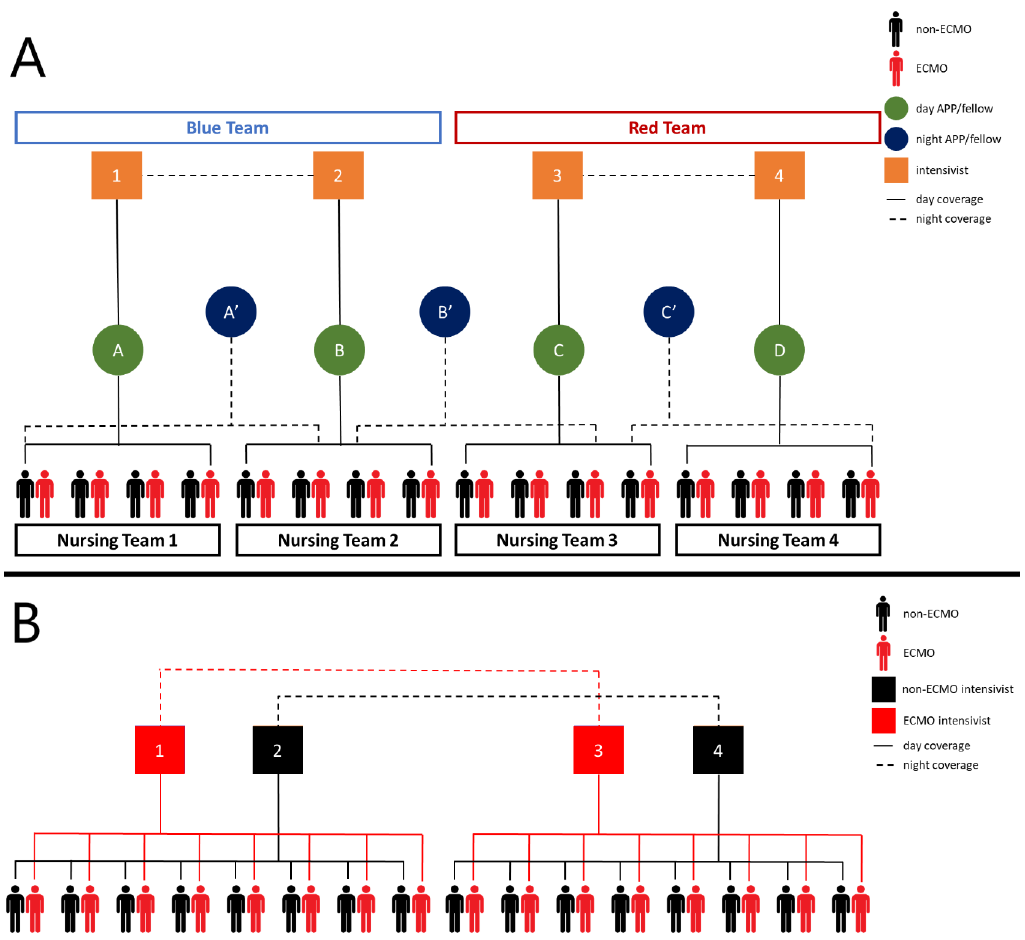
Figure 5. ( A ) Initial intensivist/( B ) provider care team schematic. The biocontainment unit (BCU) is split into two teams. During the day, each intensivist oversees an advanced practice provider/fellow, and overnight one intensivist from each Table 24 h shifts. In regards to nursing, the BCU was split into four groups and one nursing teams cared for all of the patients in that group. ( B ) Revised intensivist/provider care team schematic while double bunking. The unit is split in half. Intensivist assignment changed and the rest remained the same. An ECMO and non-ECMO cover ECMO and non-ECMO patients, respectively, on their half of the unit during the day. Overnight, one ECMO intensivist covers all ECMO patients and one non-ECMO intensivist covers all non-ECMO patients. Intensivists 1 and 3 alternate between day shifts and 24 h coverage as do intensivists 2 and 4. Legend: APP—advanced practice provider.